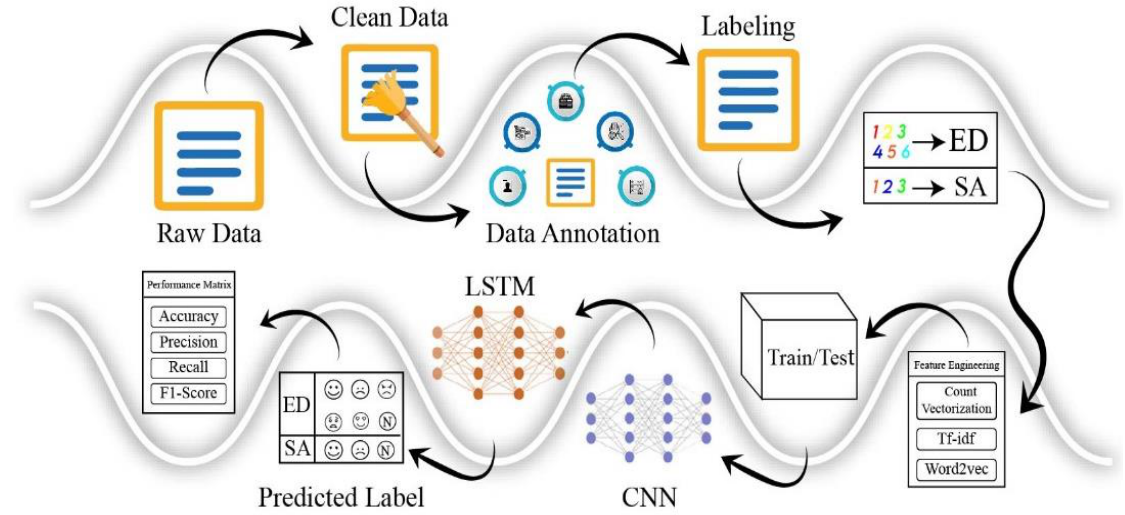
Figure 3. Proposed Methodology for Emotion Detection and Sentiment Analysis.